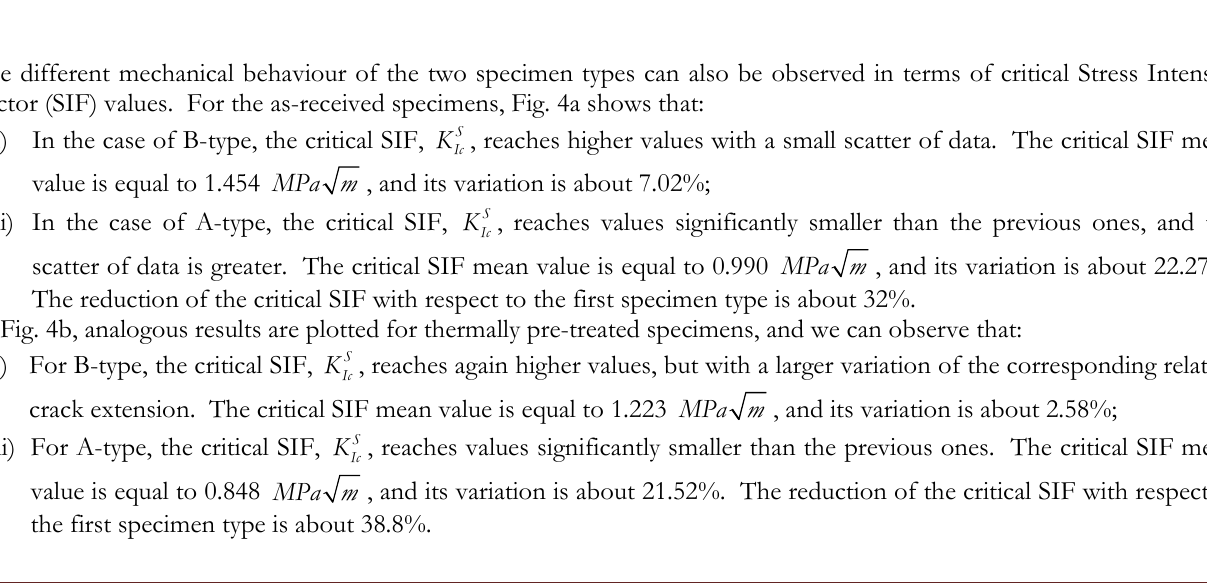
Figure 4: Critical SIF against relative crack length increment for: (a) the as-received and (b) the thermal pre-treated